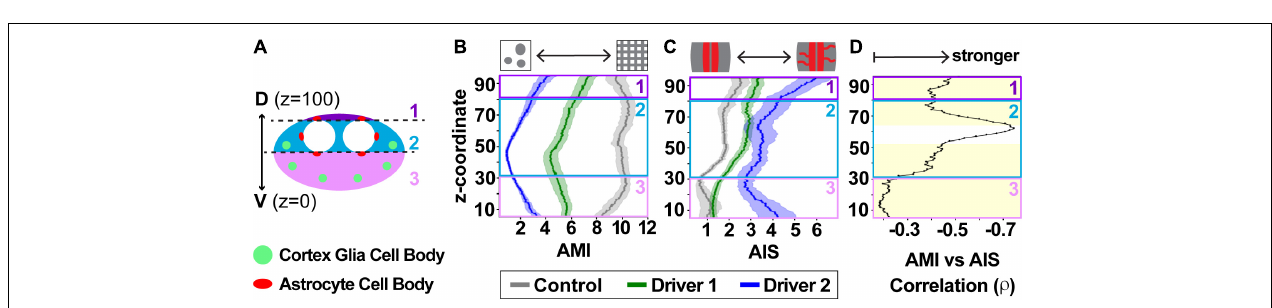
FIGURE 7 | Cortex glia morphology, aberrant astrocyte infiltration, and their relationship vary along the dorsal-ventral axis of the ventral nerve cord. (A) Cross-section depicting the larval VNC along dorsal-ventral axis, divided into three zones: above the dorsal astrocyte cell bodies (1, purple), along the neuropil (2, teal), and ventral to the neuropil (3, pink). The locations of astrocyte cell bodies are shown in red, and the stereotyped location of globular cortex glia in green. (B,C) A sliding window reveals differences along the dorsal-ventral axis in both CG AMI (B) and astrocyte AIS (C) , with control (gray), driver 1 (green), and driver 2 (blue) depicted as mean ± SEM. (D) The relationship between AMI and AIS is shown along the dorsal-ventral axis as a black line indicating the Spearman’s rank correlation coefficient ( ρ ) for any given coordinate. The yellow shaded area indicates regions where the correlation was significant between the two with p <